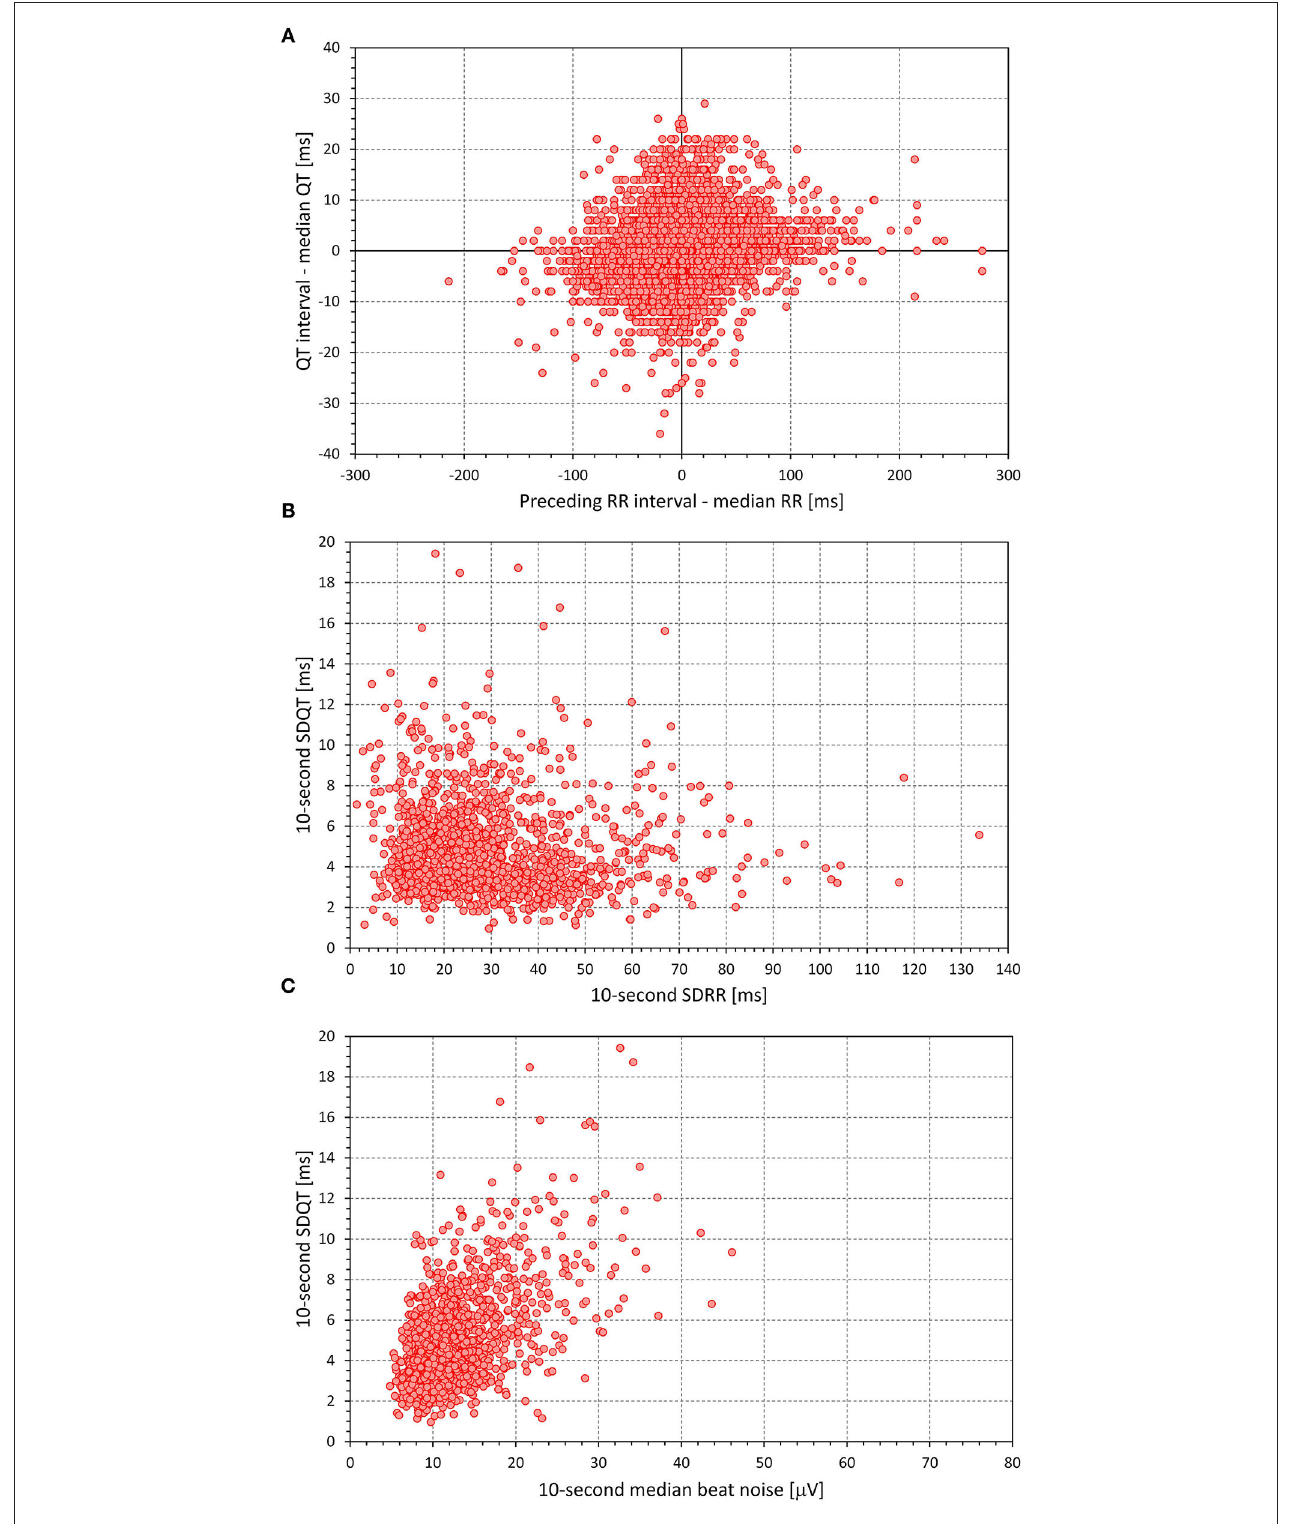
FIGURE 1 | Example of data distribution in a 36-year-old female. The top (A) shows a scatter diagram between the 1 RR and the 1 QT value measured in all individual beats accepted in the data analysis of this subject. The middle (B) and bottom (C) were derived from the data of accepted 10-s ECG segments of the Holter recordings of the subject. The middle (B) shows a scatter diagram between SDRR and SDQT values, the bottom (C) shows a scatter diagram between median beat noise and the SDQT values. Note the wide spread of the data in all panels and the visible data trend in the bottom panel.